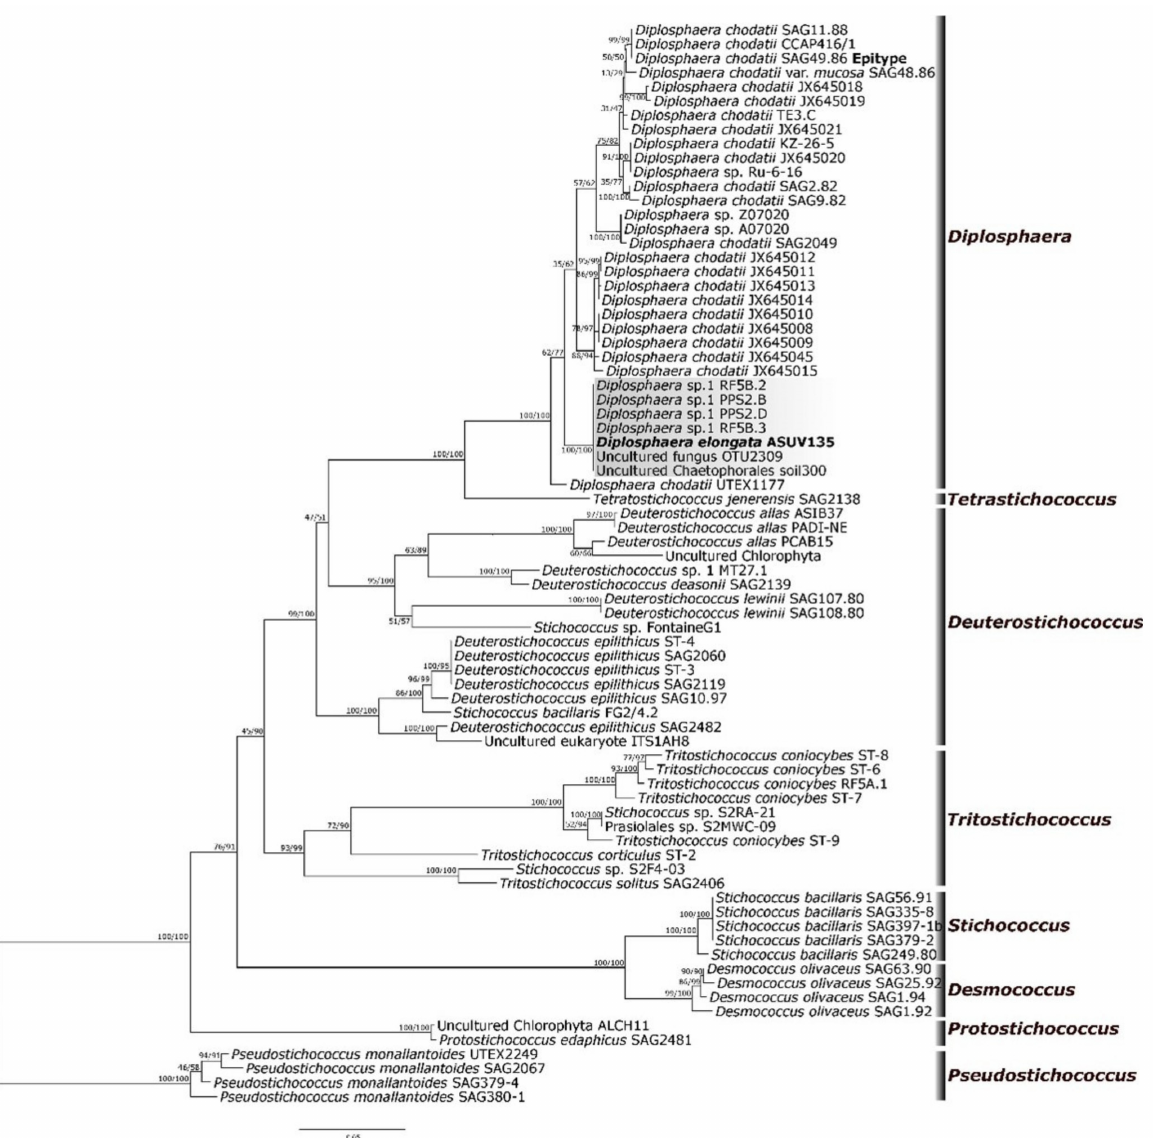
Figure 3. Phylogenetic tree based on the concatenated SSU and ITS dataset of 75 taxa of Stichococcus - like organisms. Diplosphaera elongata sp. nov. is highlighted in gray. Values at nodes indicate statistical ML bootstrap supports and Bayesian posterior probabilities (BS/PP). Scalebar shows the estimated number of substitutions per